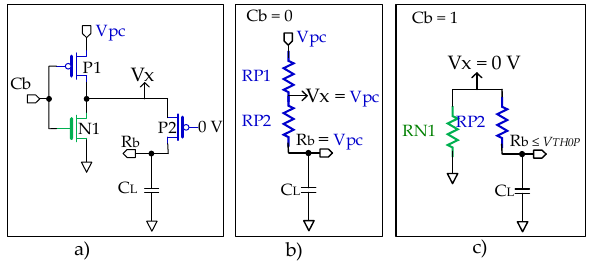
Figure 4. Proposed adiabatic PUF; ( a ) active transistors during charging and discharging the response node, ( b ) RC equivalent model at Cb = 0 V, and ( c ) RC equivalent model at Cb = 1.8 V.